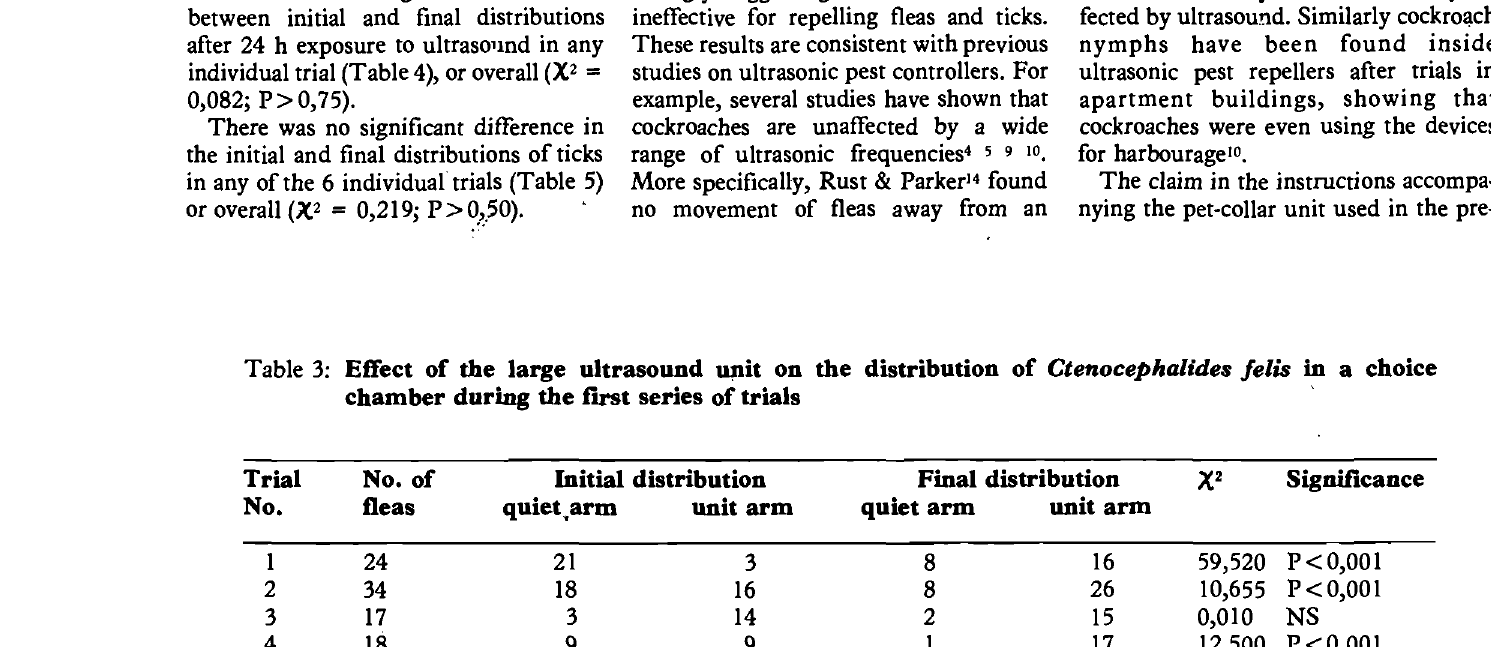
Table 4: Effect of the large ultrasound unit on the distribution of Ctenocephalides felis in a choice chamber during the second series of